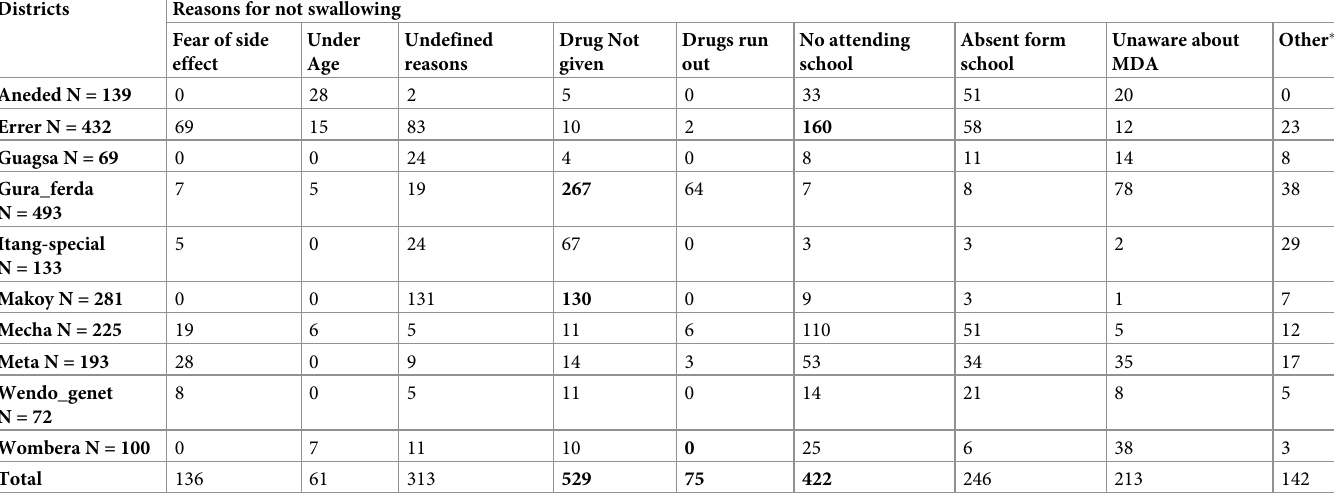
Table 4. Number of self-reported reasons for not swallowing drugs in ten districts of Ethiopia, 2019 (N = 2137). Districts Reasons for not